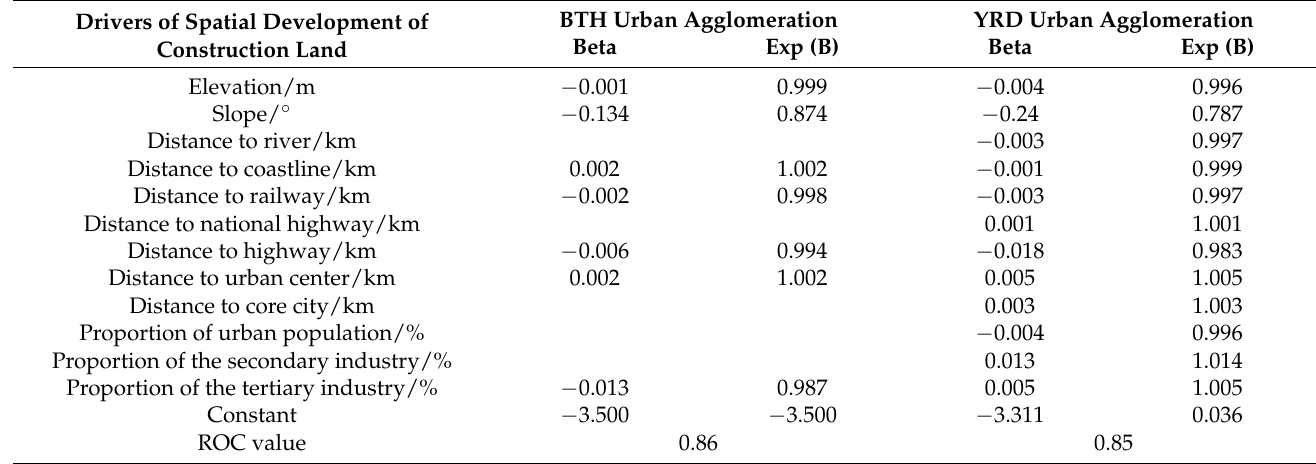
Table 4. Contribution of driving factors to the spatial development of construction land in the BTH and YRD urban agglomerations. The significance of all included variables was less than